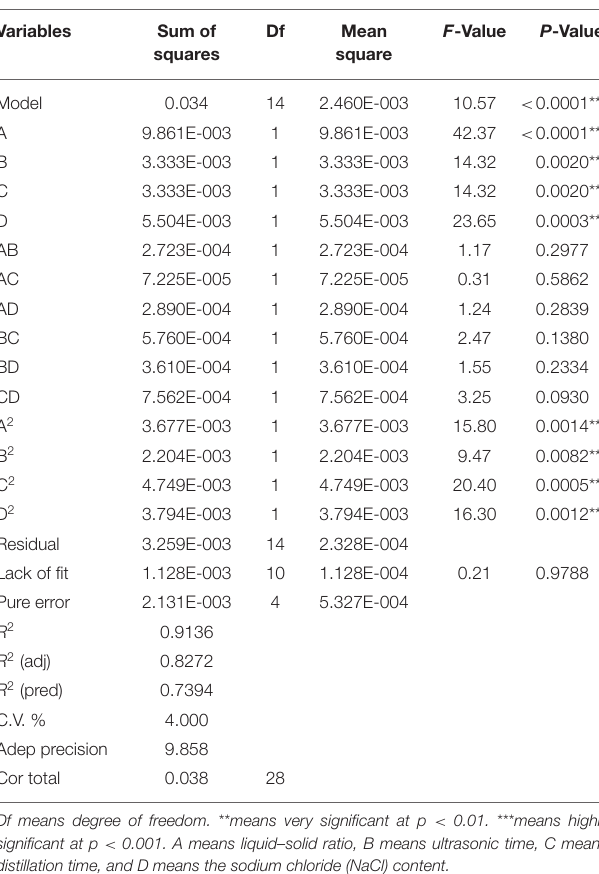
TABLE 3 | The ANOVA for fitted quadratic polynomial regression model. F -Value Variables Sum of Df Mean squares square